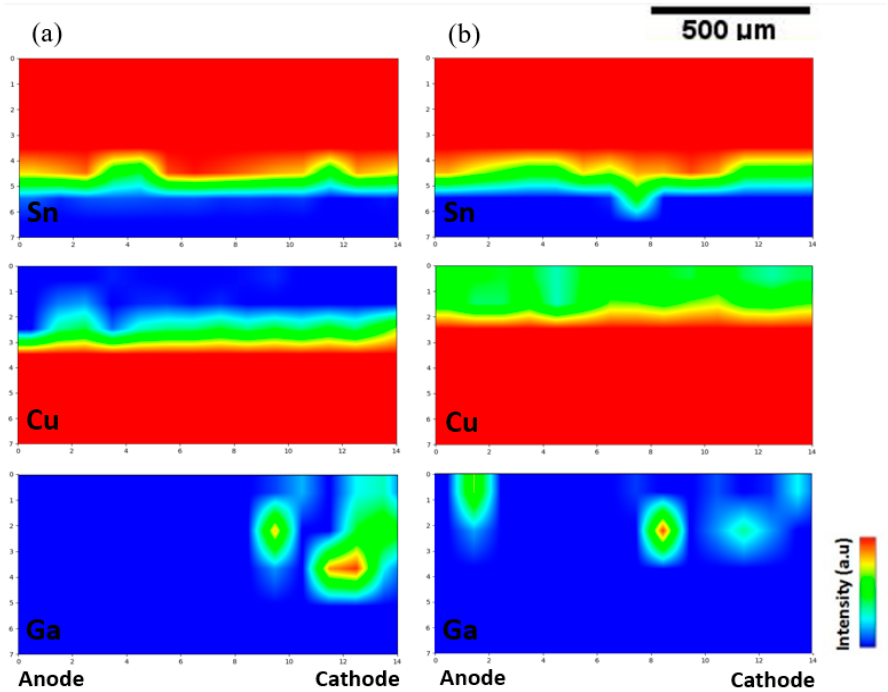
Figure 8. Synchrotron micro-XRF mapping of Sn–0.7Cu–0.05 Ga: ( a ) Sn–0.7Cu–0.05Ga under electromigration, ( b ) Sn–0.7Cu–0.05Ga under electromigration and thermal ageing.